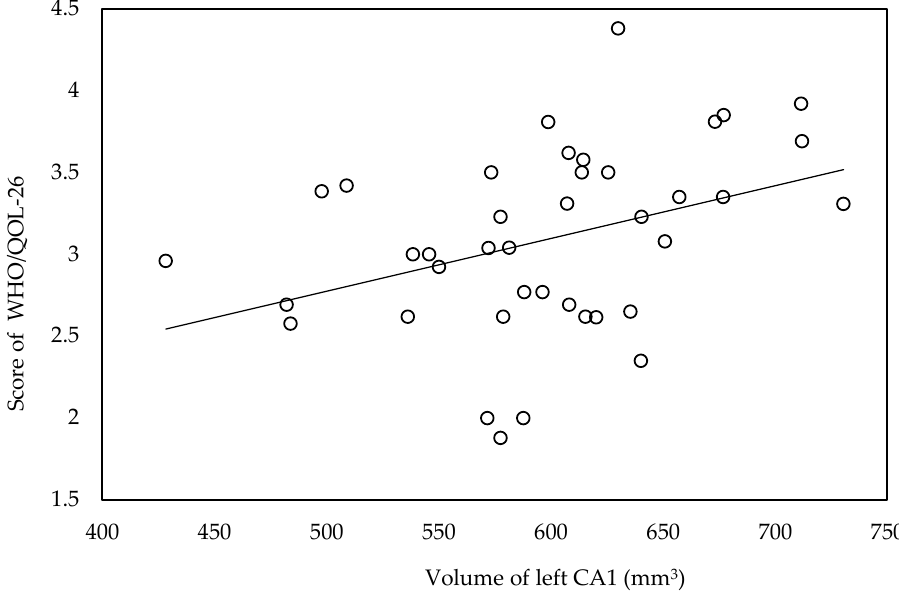
Figure 2. Scattergram for the association between WHO/QOL-26 score and volume of left CA1.